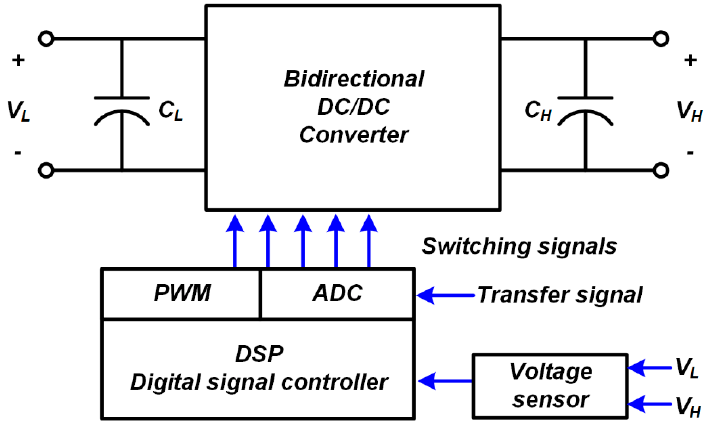
Figure 9. A bidirectional circuit diagram of rapid energy conversion.